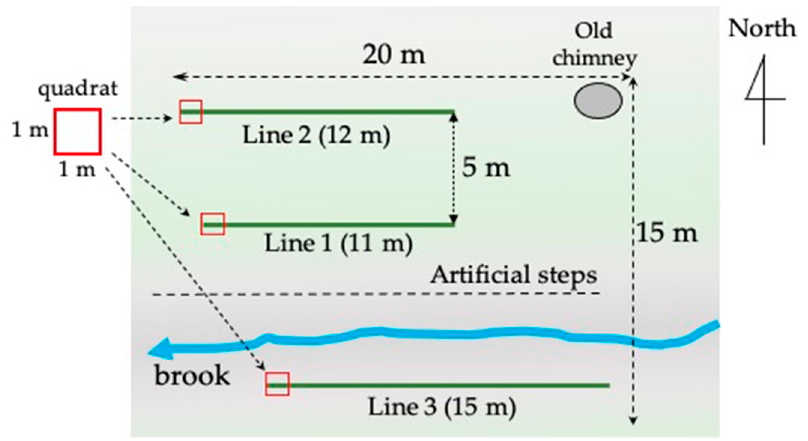
Figure 1. Schematic diagram for vegetation survey at our study site located in the abandoned con- centrator.